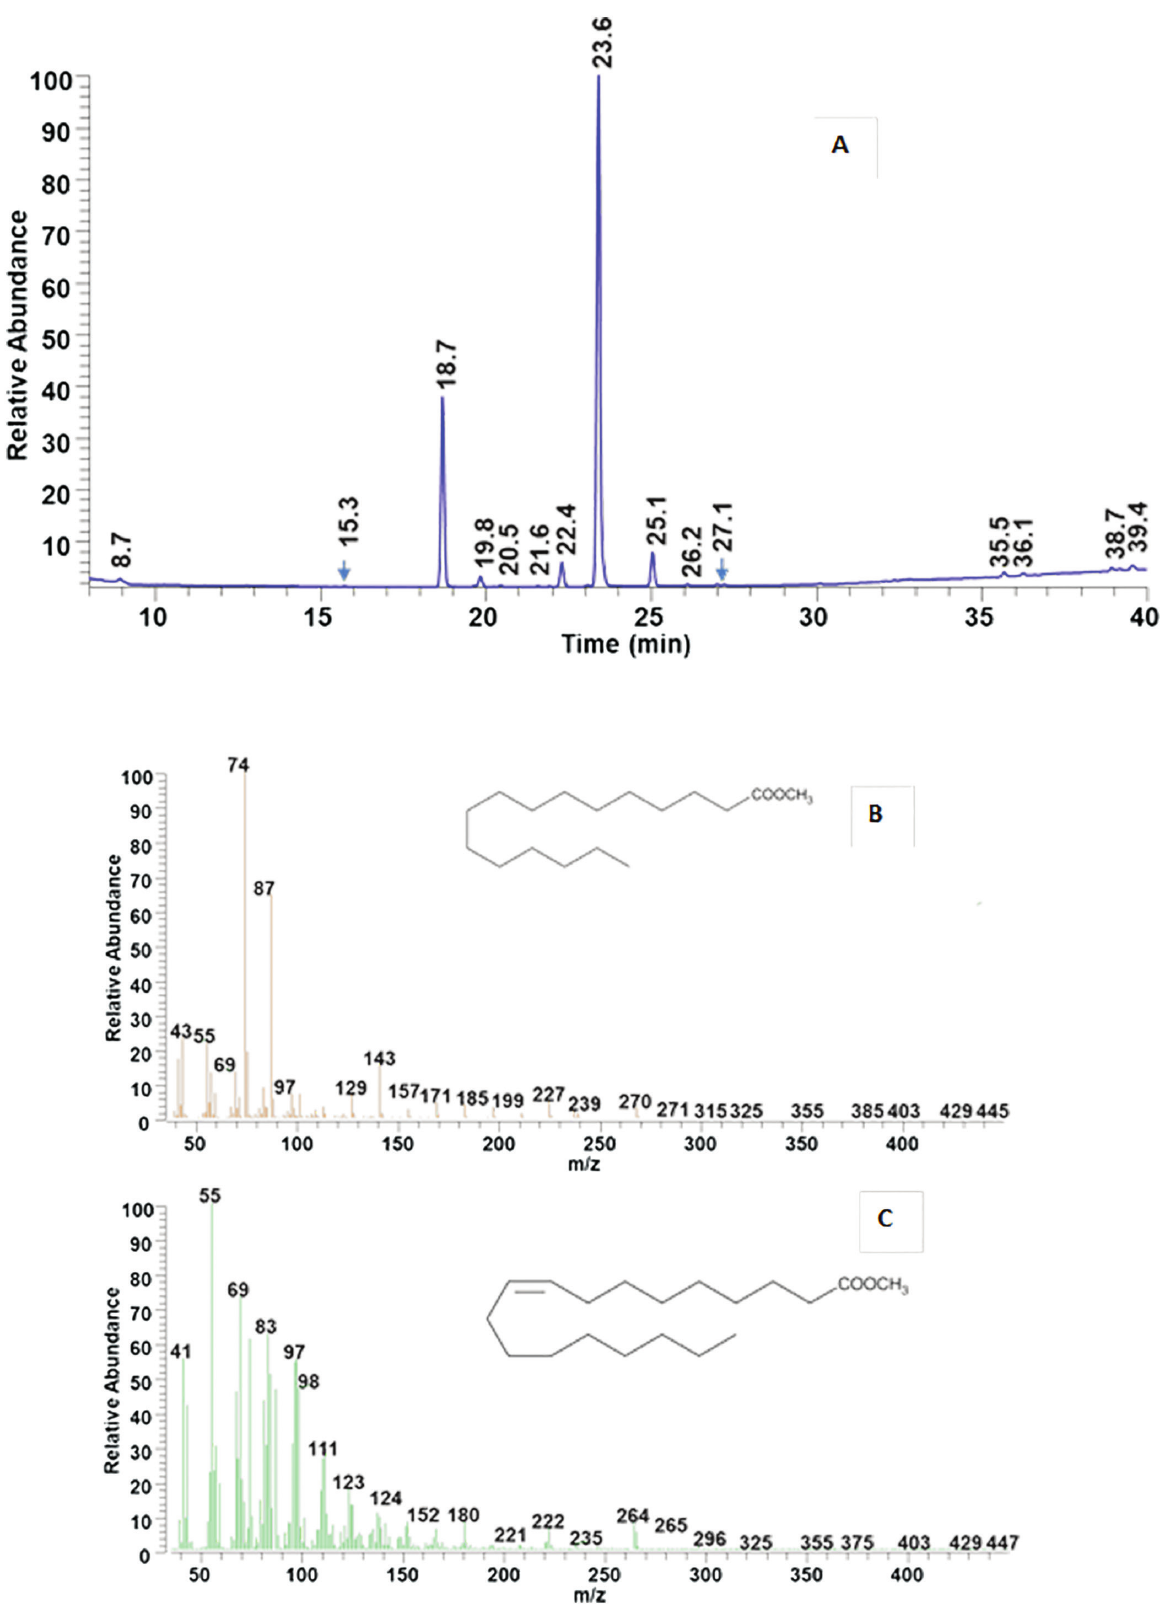
Figure 4: GC spectrum of biodiesel (a). Mass spectra of palmitic acid, methyl ester (b) and oleic acid, methyl ester